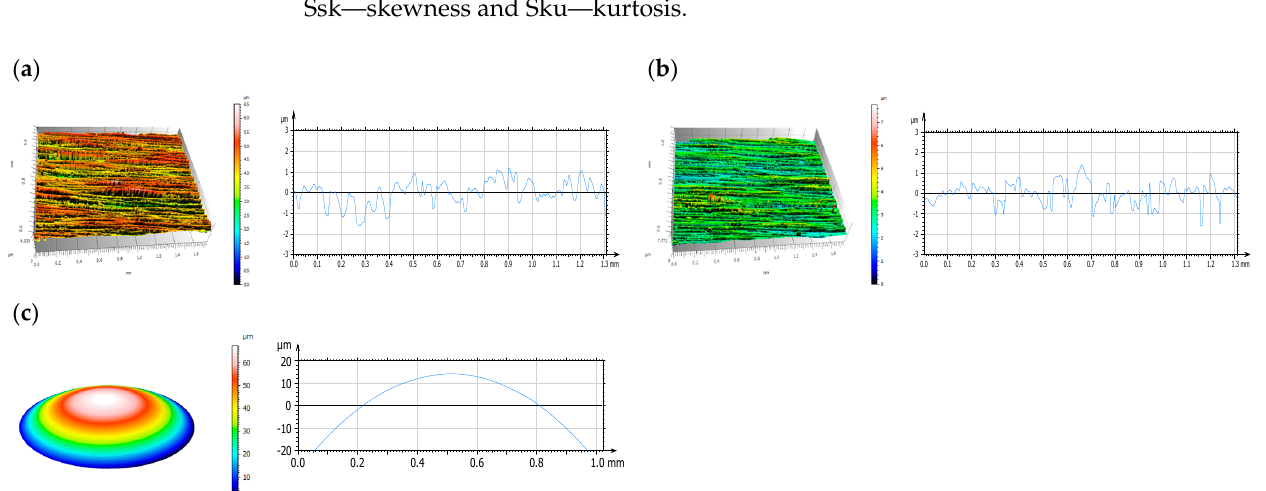
Figure 4. Surface topography: ( a ) the W-DLC coated HS6-5-2C steel disc, ( b ) the uncoated HS6-5-2C steel disc and ( c ) the 100Cr6 steel ball, before the tribological tests.